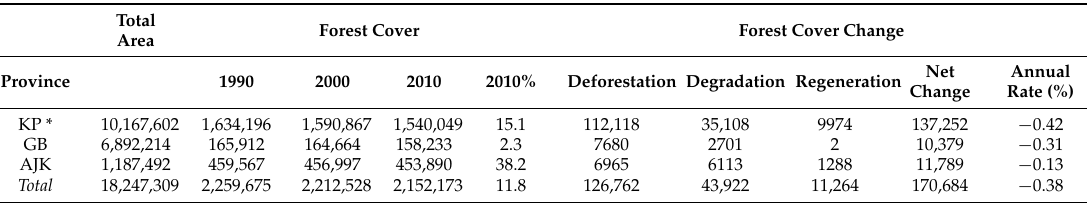
Table 4. Change of forest cover (area in ha).